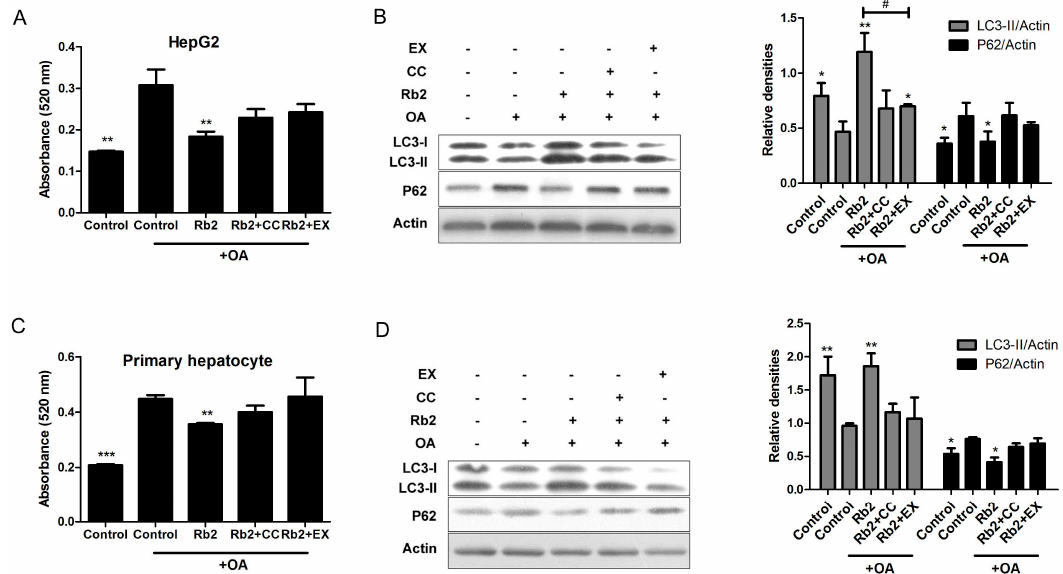
Figure 8. Inhibition of sirt1 and AMPK blocked Rb2-induced hepatic autophagy. HepG2 cells ( A , B ) and primary mouse hepatocytes ( C , D ) were pretreated with 50 µmol/L Rb2 for 4 h in the presence or absence of the sirt1 inhibitor EX-528 (EX) and the specific AMPK inhibitor Compound C (CC), and then subjected to OA (1 mmol/L for HepG2 and 2 mmol/L for primary mouse hepatocytes) exposure for 12 h. For lipid content determination, intracellular TG were stained by Oil red O (ORO). ORO was then eluted with isopropanol and the optical absorbance of the eluate was measured at 520 nm ( n = 3). Data are expressed as mean ± SE from three independent experiments. * p < 0.05, ** p < 0.01 and *** p < 0.001 compared with the group that was pretreated with vehicle (DMSO) prior to OA exposure. # p < 0.05 compared between the two indicated groups. For autophagic activity evaluation, levels of LC3-II and P62 were detected and quantified by Western blotting analysis.